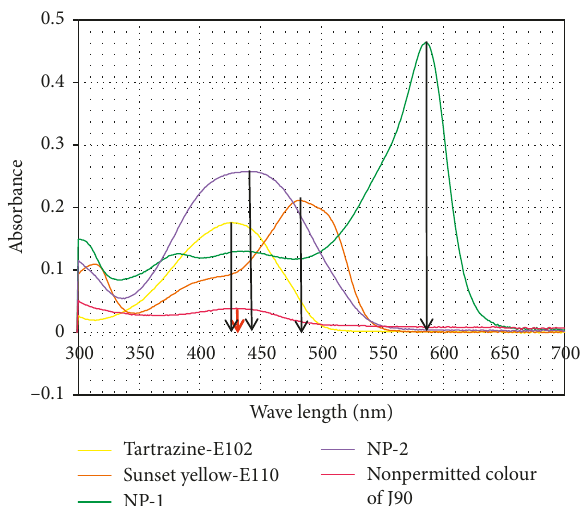
Figure 5: Spectral analysis of J90 jelly sample with permitted and nonpermitted colour standards. NP-1: nonpermitted Bromocresol purple; NP-2: nonpermitted Metanil yellow.